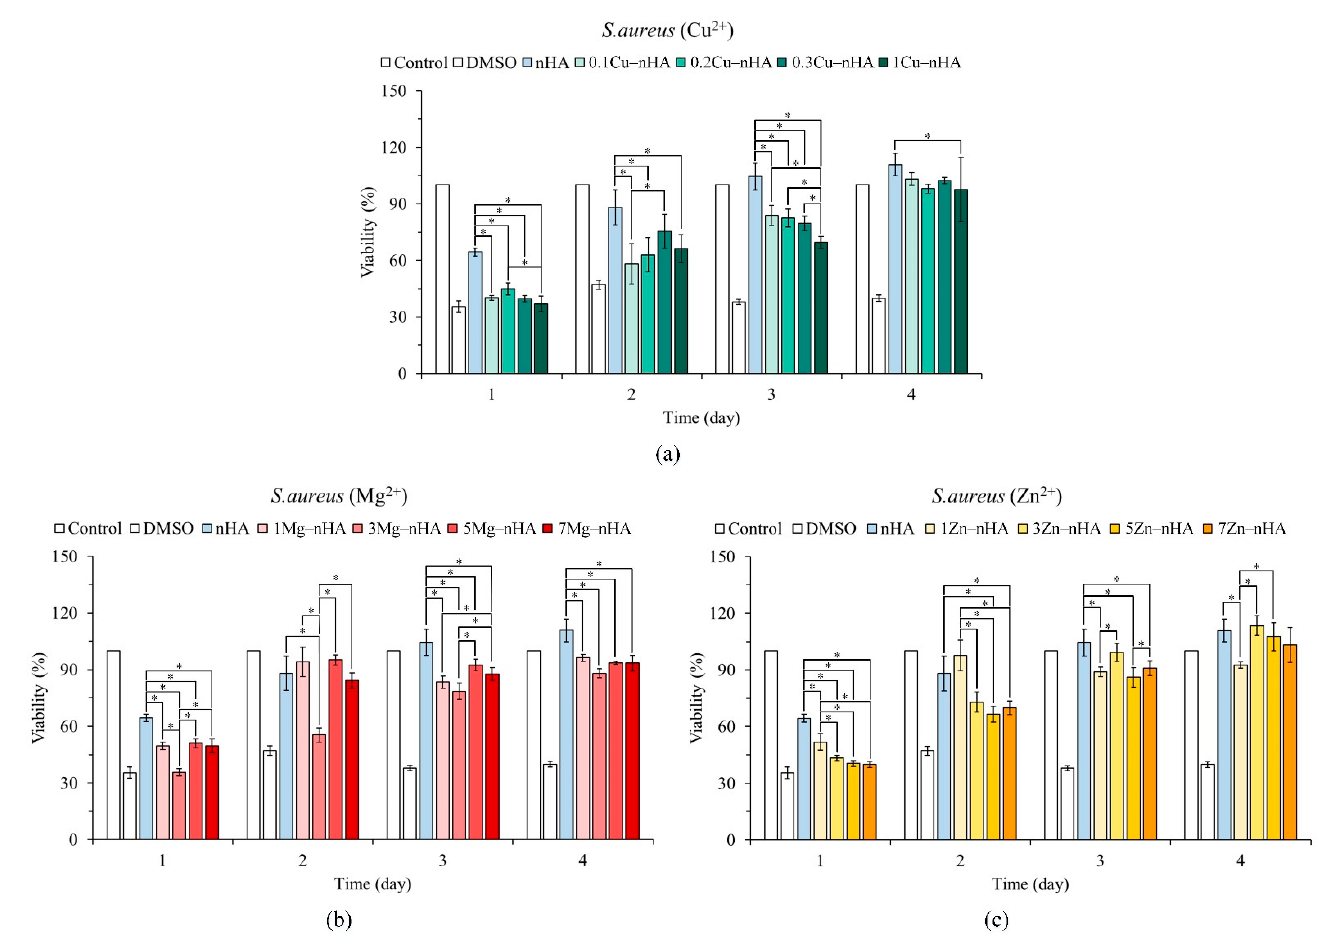
Figure 4. Relative quantitative antibacterial ability against gram-positive S. aureus in the presence of different ionic concentrations of Cu 2+ ( a ), Mg 2+ ( b ), and Zn 2+ ( c ), the rod-shaped nanoapatites with different ion concentrations ( n = 3; * indicates significantly different p < 0.05).